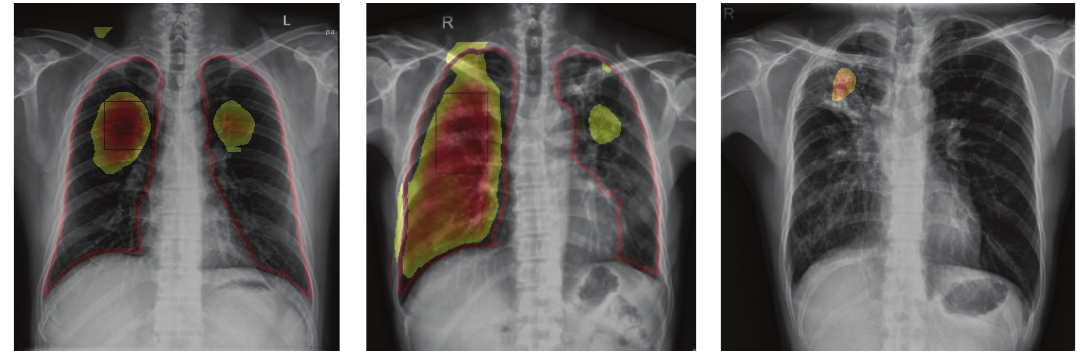
Figure 9: Saliency maps for X-rays from Shenzhen No. 3 People’s